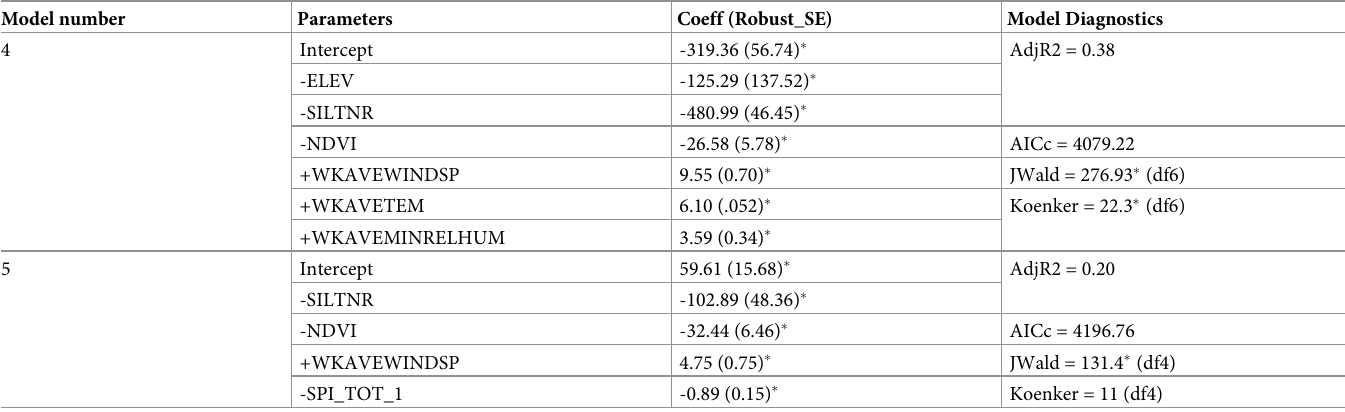
Model 4 provides the optimized model for phloem feeder abundance based on diagnostics. Model 5 provides the best fitting model adjusted to include hypothesized drivers of phloem feeder abundance and distribution. AdjR2 is adjusted R-Squared; AICc is Akaike’s Information Criterion; JWald is Joint Wald Statistic; model variable sign is plus or minus (+/-); coefficient and Statistic significance are indicted by asterisks (p < 0.01); df indicates degrees of freedom. Response variable was INS_PHLOEMT_1 (n = 486) for all